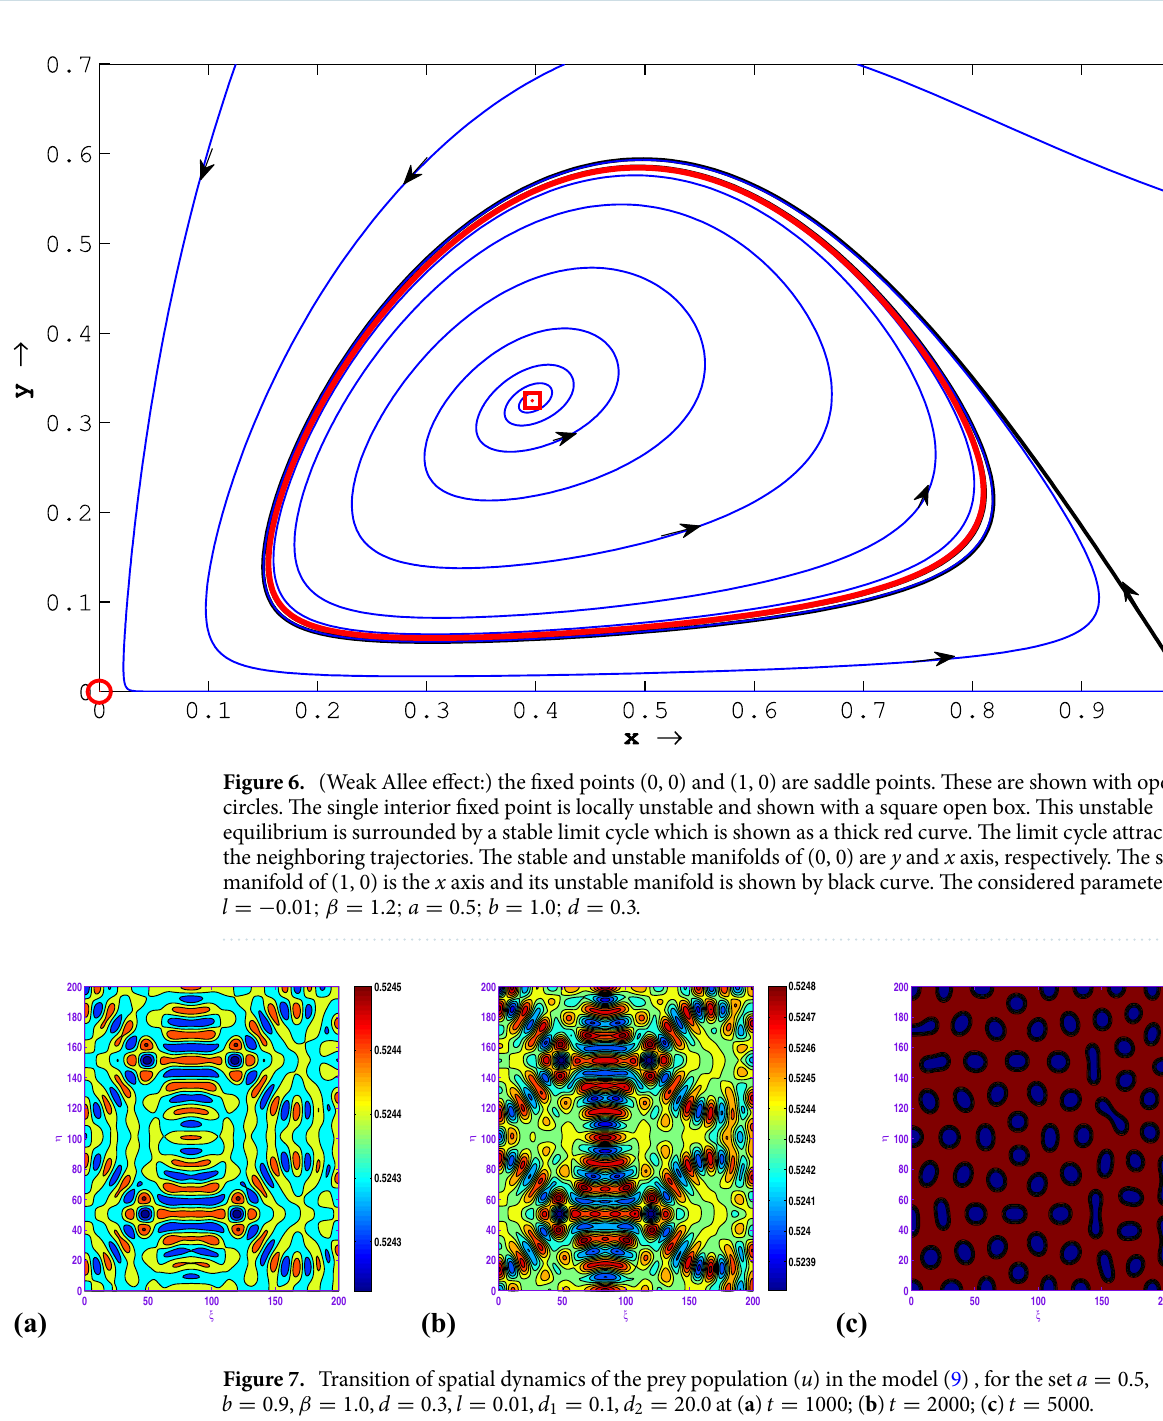
t = 1000 ; ( b ) t = 2000 ; ( c ) t = 5000 d 1 = 0.1 , 2 = 20.0 at ( a )